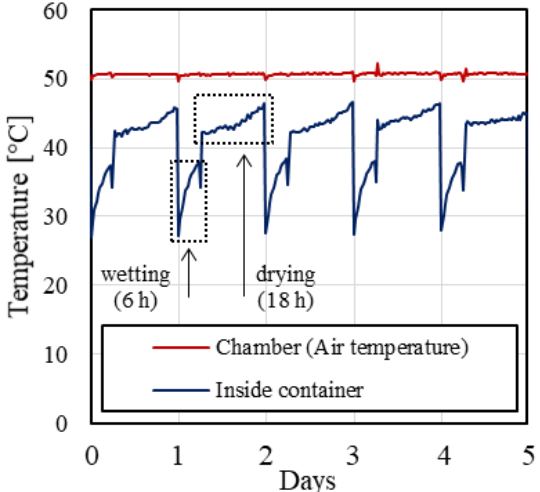
Figure 1. Temperature of environmental chamber and inside container during wet–dry cycles. The number of cycles (i.e., 50 cycles) was selected to simulate a 25-year-long service life of externally bonded reinforcements that are fully soaked twice a year [27]. Furthermore, this specific number of wet–dry cycles is the same recommended by EN 12,467 [48] to investigate the durability of fiber-cement flat sheets, which confirms that it represents an adequate number of cycles for inorganic